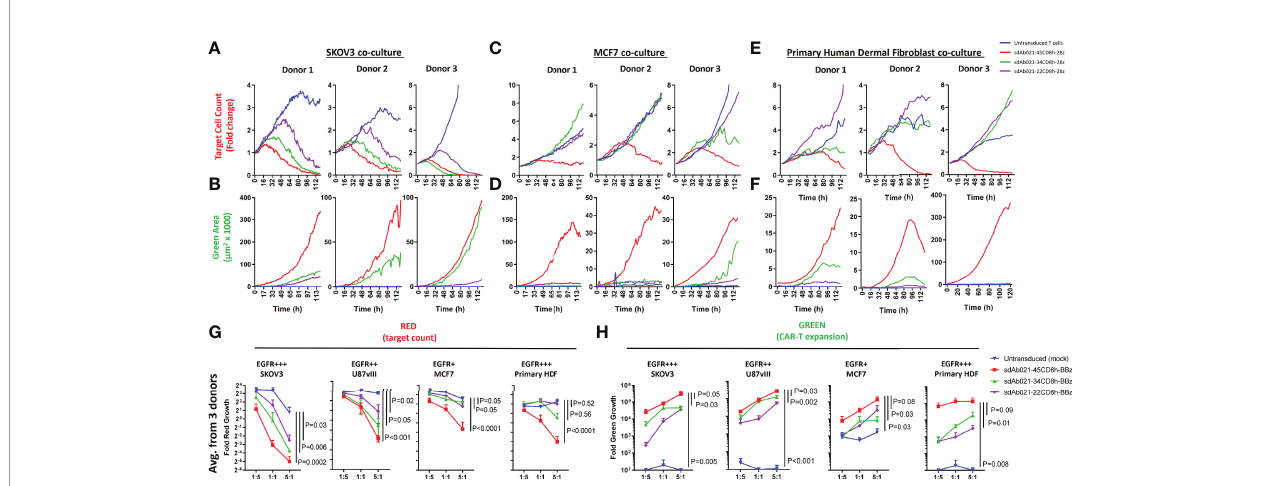
FIGURE 5 | Hinge truncation progressively diminishes tumor cell killing and expansion of primary sdCAR-T cells in response to EGFR expressing target cells. Concentrated lentiviral particles encoding hinge-modi fi ed EGFR-speci fi c sdAb021 CARs as well as a GFP marker were generated. Peripheral blood T cells were isolated from 3 independent healthy human donors before polyclonal expansion and lentiviral transduction. Varying doses of sdCAR-T cells or mock transduced cells (empty CAR backbone lentivirus) were placed at an E:T ratio of 1:1 in low density co-culture (2000 sdCAR-T cells and 2000 target cells). Co-cultures were examined over 7 days via live fl uorescence microscopy (Incucyte) to differentiate red- fl uorescent (NLS-mKate2) target cell counts or total area of green- fl uorescent (NLS-NanoGreen) CAR-T cells. (A, B) Depicts the response to EGFR-high SKOV3 targets, (C, D) depicts the response to EGFR-low MCF7 targets, (E, F) depicts the response to EGFR-high healthy donor human dermal fi broblast cells. Each graph depicts automated cell counts or fl uorescent areas from a single independent experiment. (G) Day 5 mean fold change in various target cell growth at varying E:T ratio for hinge-variant EGFR-sdCAR-T cells derived from 3 donors is shown +/- SEM, P values are derived from a two-way ANOVA comparison of response curves for untransduced T cell co-cultures with CAR-T cells expressing hinge-truncated constructs. (H) Similarly the mean EGFR-sdCAR-T fold expansion at day 5 of hinge-variant CAR co-cultures from 3 donors is shown +/-SEM is shown. P values are derived from a two-way ANOVA comparison on 45CD8h-hinge containing constructs with other constructs tested in